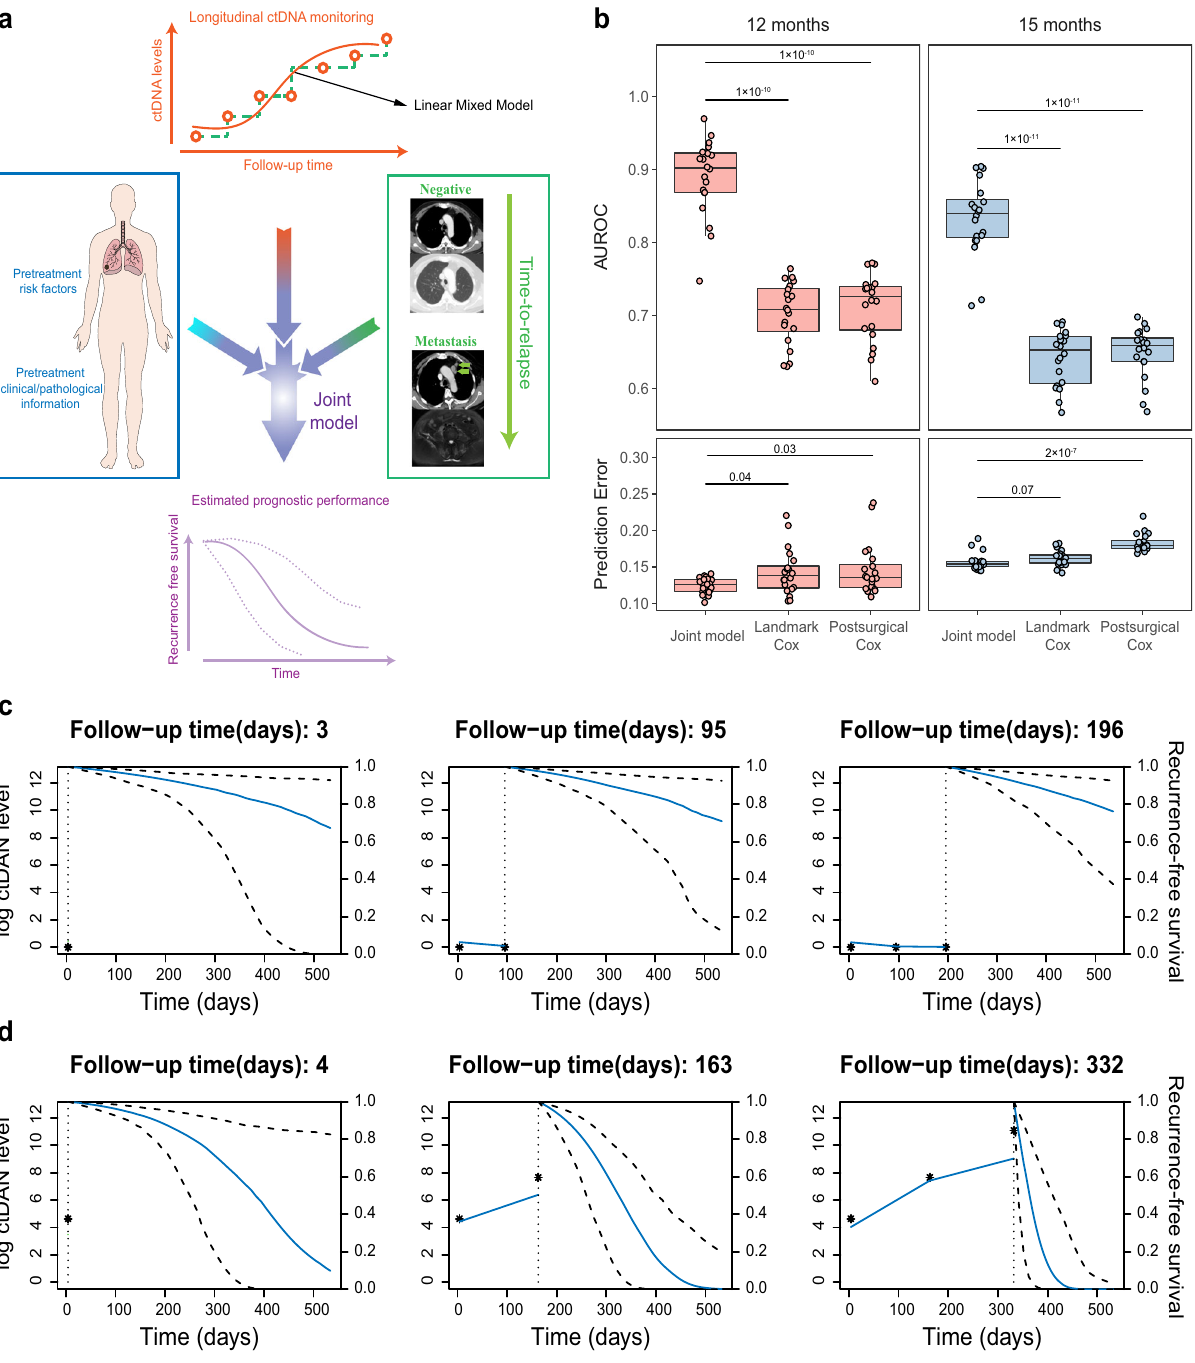
Fig. 4 Serial ctDNA monitoring for personalized dynamic risk prediction. a Conception of Joint model. b The comparison of model performance between the joint model and cox models (testing datasets). Fivefold cross-validation were repeated for 20 times. The p value is calculated using two-sided Wilcoxon signed-rank test. ns: not signi fi cant; * p <0.05; ** p <0.01; *** p <0.001. Center line, median; box limits, upper and lower quartiles; whiskers, 1.5x interquartile range. AUROC: areas under the receiver-operating characteristics curves. c , d Personalized dynamic risk prediction for patients P062 ( c ) and P017 ( d ). From left to right, predictions were calculated accounting for ctDNA that measured previously and were updated when new measure became available. The vertical dotted lines represent the time point of the last ctDNA measurement. To the left of the vertical line is fi tted longitudinal trajectory. To the right of the vertical (cid:1) (cid:3) line is the median estimator for recurrence-free probability with 95% pointwise uncertainty band. LogctDNAlevel ¼ ln meanVAF þ 10 (cid:2) 6 (cid:2) ln10 (cid:2) 6